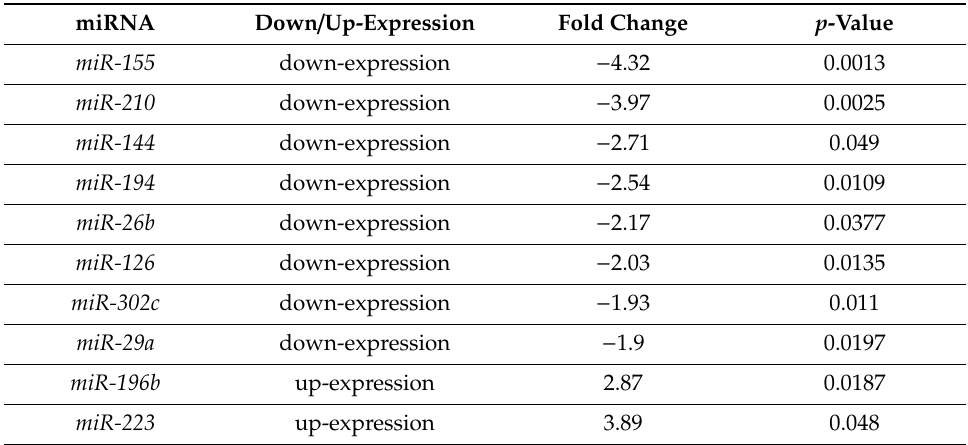
Table 1. MicroRNA expression changes in Caco-2 cells treated with 5 mM IP6 as compared with the control, as deduced from microRNA microarray analysis. Changes were considered significant for p < 0.05. miRNA Down / Up-Expression Fold Change p -Value miR-155 down-expression − 4.32 0.0013 miR-210 down-expression − 3.97 0.0025 down-expression − 2.71 0.049 − 2.54